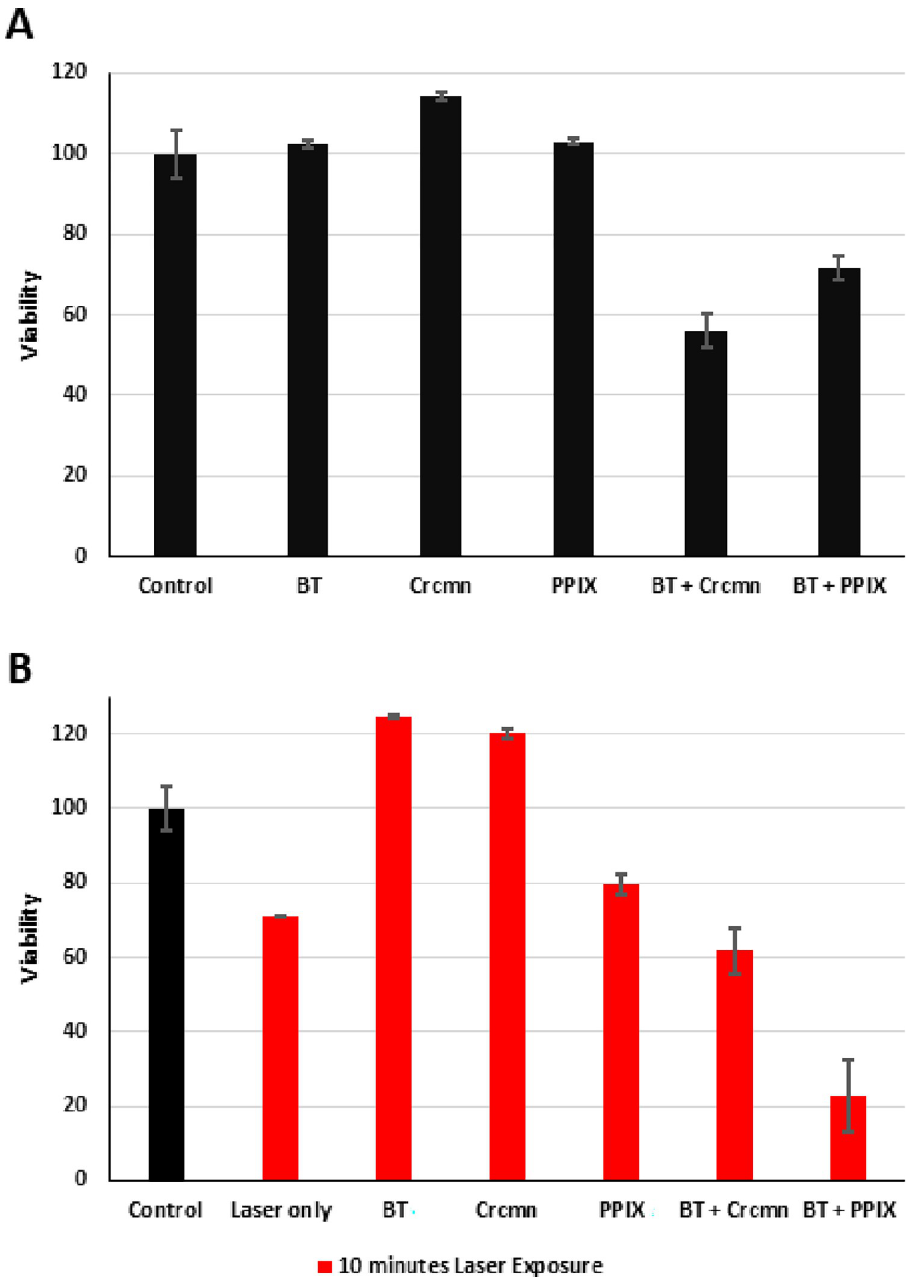
Fig 5. ( A ) Viability of S . aureus after dark treatment with BT (Barium Titanate) or PPIX (Protoporphyrin IX) or Crcmn (Curcumin) or HNP-PS conjugates. ( B ) Viability of S . aureus after photodynamic treatment using pulsed NIR laser with either BT+PPIX or BT+Crcmn or HNP and PSs alone normalized to constant power across all irradiated samples with reference to that of laser alone. Cell counts across all labels were kept constant. The error bars indicate standard errors of 6 samples each of HNP-PS conjugates with laser irradiation, 4 samples each of HNP-PS conjugates in dark and 2 samples of each of the rest. Each label represents data for constant cell (200 μ l of 10 3 –10 4 cells/ml) and nanoparticle/photosensitizer (20 μ l of 400 μ g/ml) concentrations as detailed in methods.